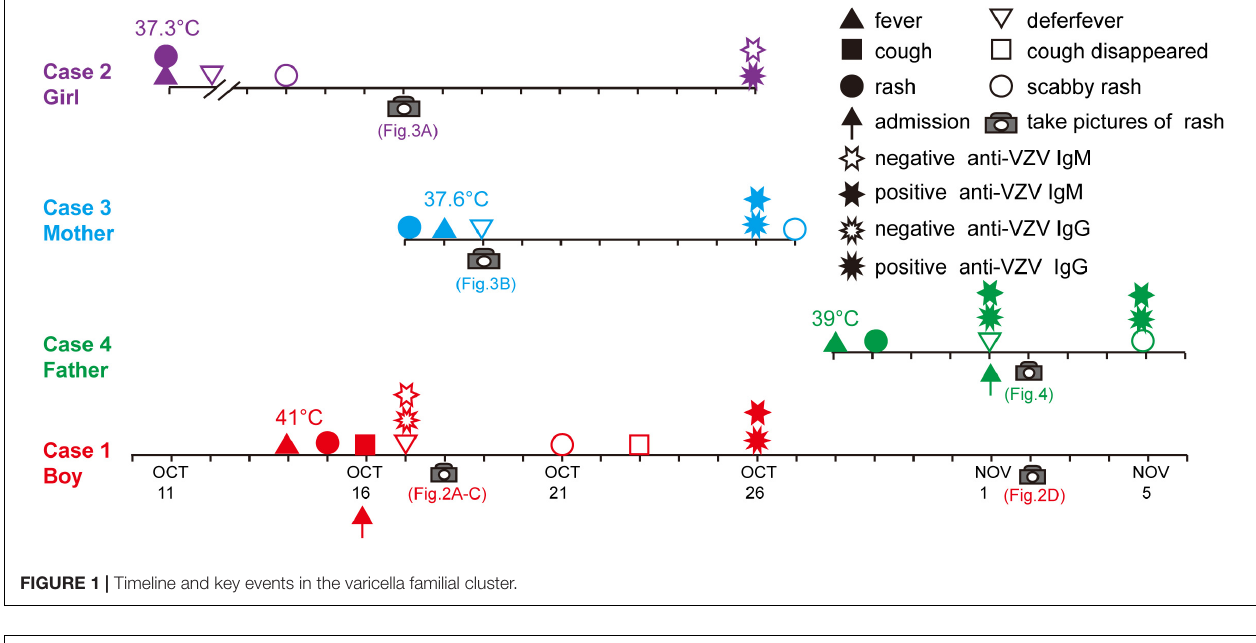
FIGURE 1 | Timeline and key events in the varicella familial cluster.